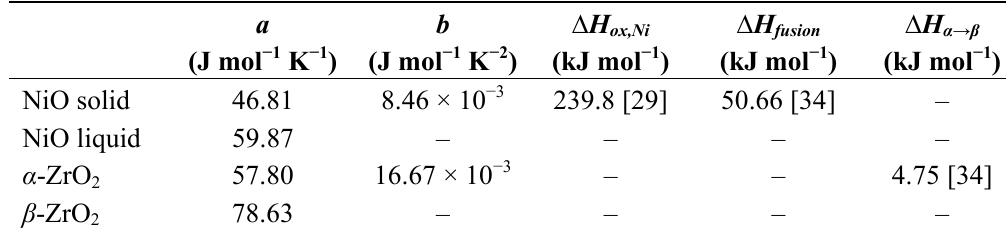
Table 4. Thermodynamic constants for NiO and ZrO is the enthalpy of nickel oxidation (Ni +1/2O constant pressure), ∆ H ox ∆ H the fusion enthalpy of nickel oxide (melting point of NiO is T fusion the enthalpy for zirconia phase change (from α to β phase). C ∆ H α→β = a + bT equation C p,m